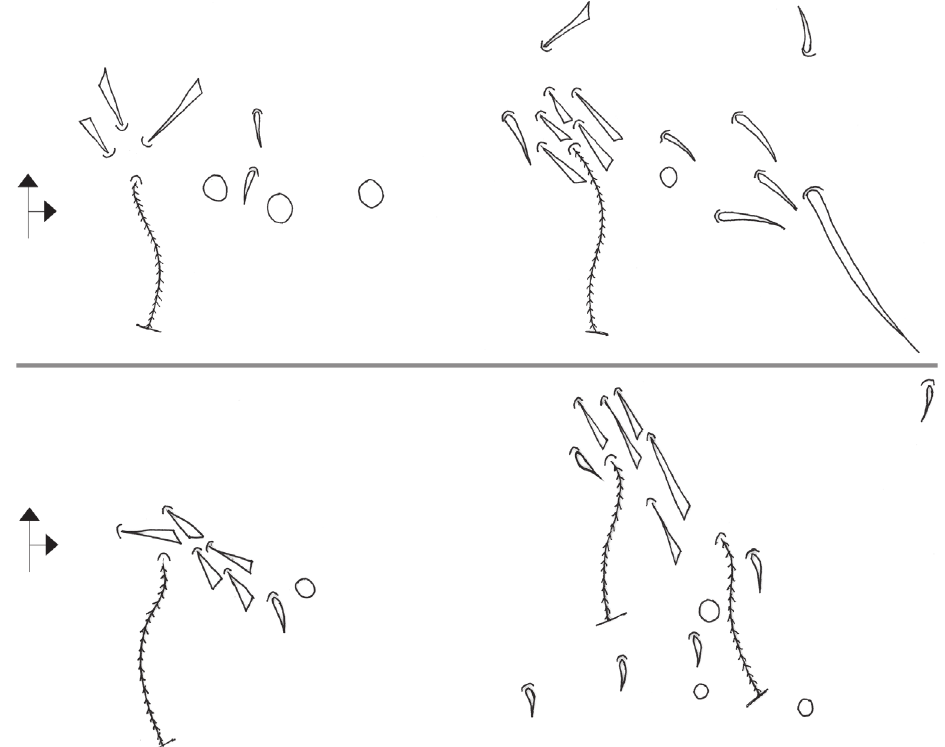
Figure 13. Dorsal macrochaetae distribution of Tyrannoseira diabolica sp.